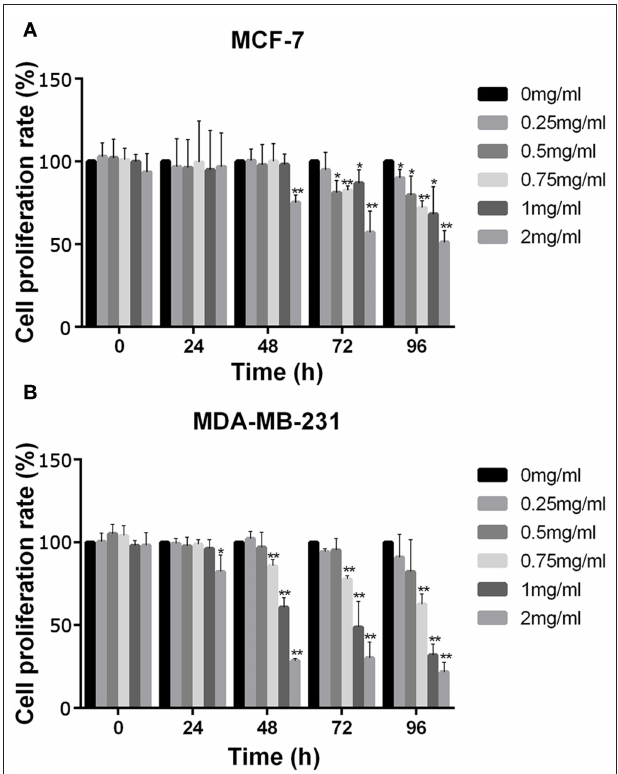
FIGURE 9 | The increase in APS concentration significantly inhibited the activity of BC cells MCF-7 and MDA-MB-231. Optical density values at indicated concentrations of APS in MCF-7 (A) and MDA-MB-231 (B) cells were detected by CCK-8 assay, and absorbance was read at 450nm. * p < 0.05, ** p < 0.01 vs. control (0